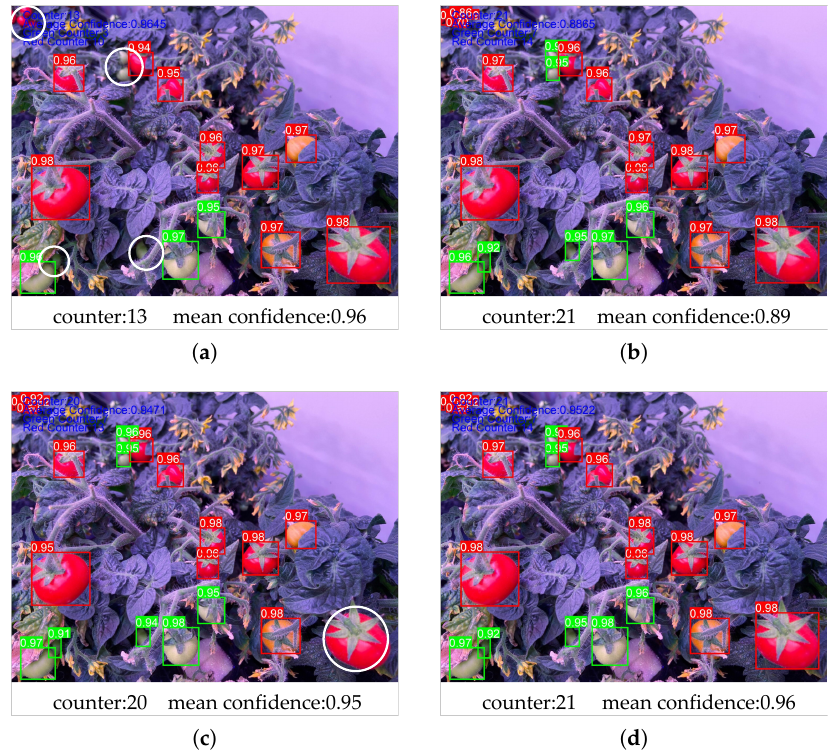
Figure 6. Comparison of multi-layer detection results. Detection results for ( a ) large targets, ( b ) medium targets, ( c ) small targets, and ( d ) multi-layer target fusion detection. Borders and text background colors indicate that the recognized classification was “green” or “red” fruit. White circle callouts indicate tomato fruits that were not correctly